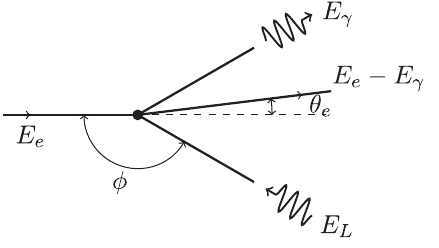
FIG. 1. The kinematics of the Compton